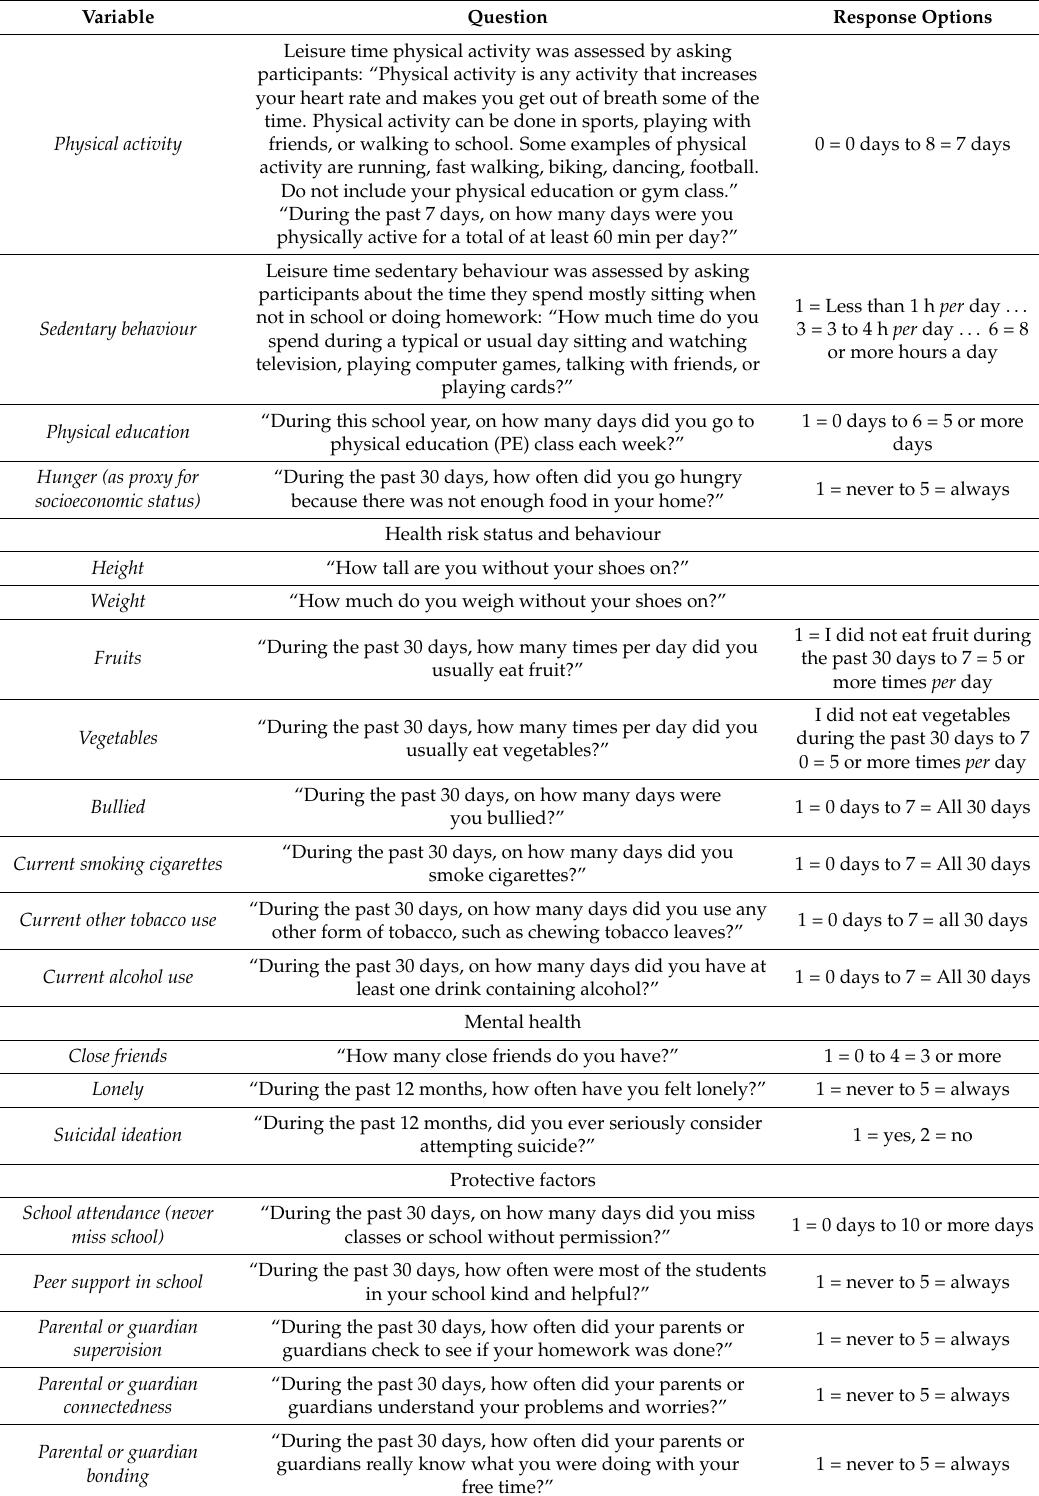
Table 1. Variable